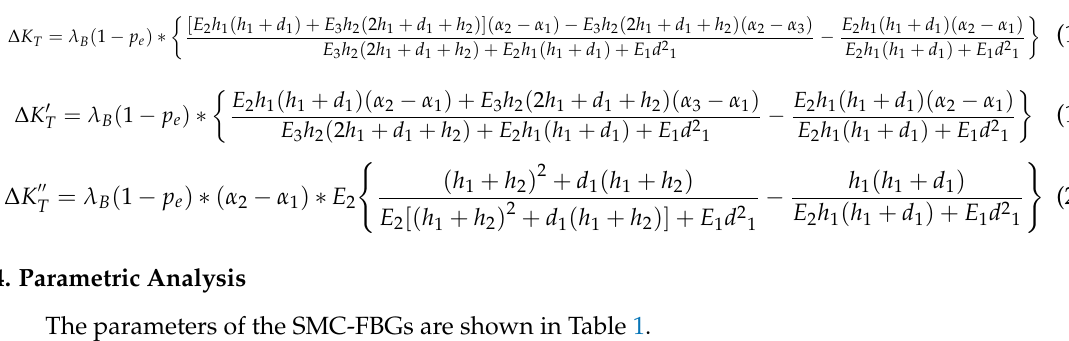
Table 1. Parameters of the stepped-metal coated-fiber Bragg grating (SMC-FBGs).